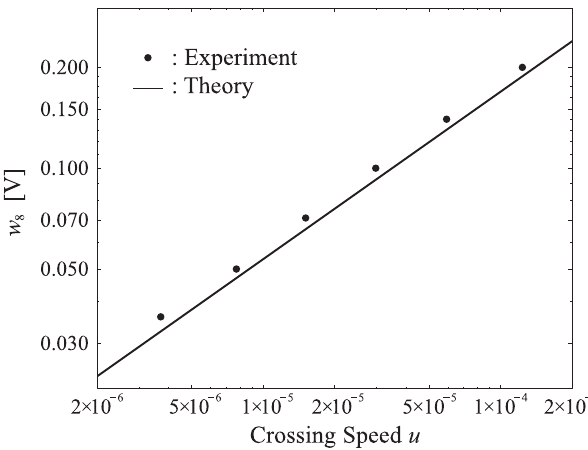
FIG. 8. Fraction of ions remaining after integer resonance crossing. Fractional ion losses obtained with various dipole perturbation strengths are plotted as a function of crossing speed u . The bare tune ν 0 is reduced from 9.5 to 7.5. Filled and open symbols show, respectively, experimental data and W ARP sim- ulation results in which the initial ion distribution is Gaussian with a temperature of 0.5 eV.